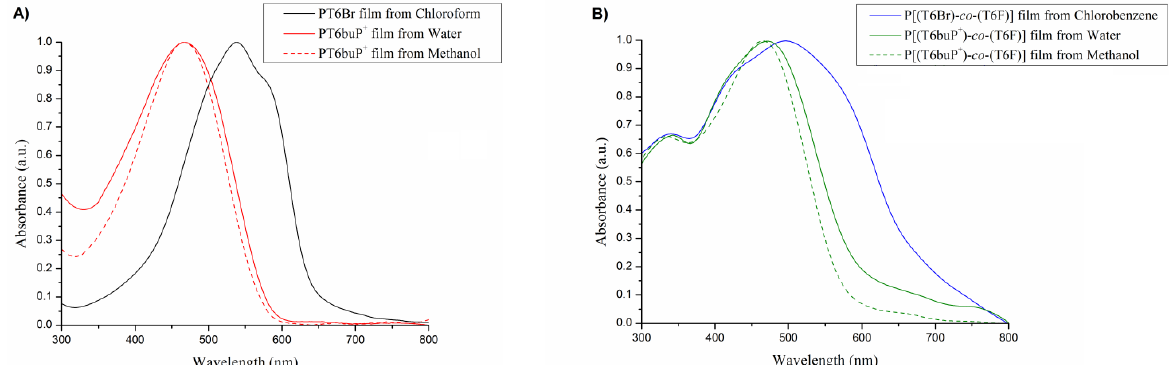
Figure 3. IR spectra of PT6Br (black line), PT6buP + (red line), P[(T6Br)- co -(T6F)] (blue line) and P[(T6buP + )- co -(T6F)] (green line).